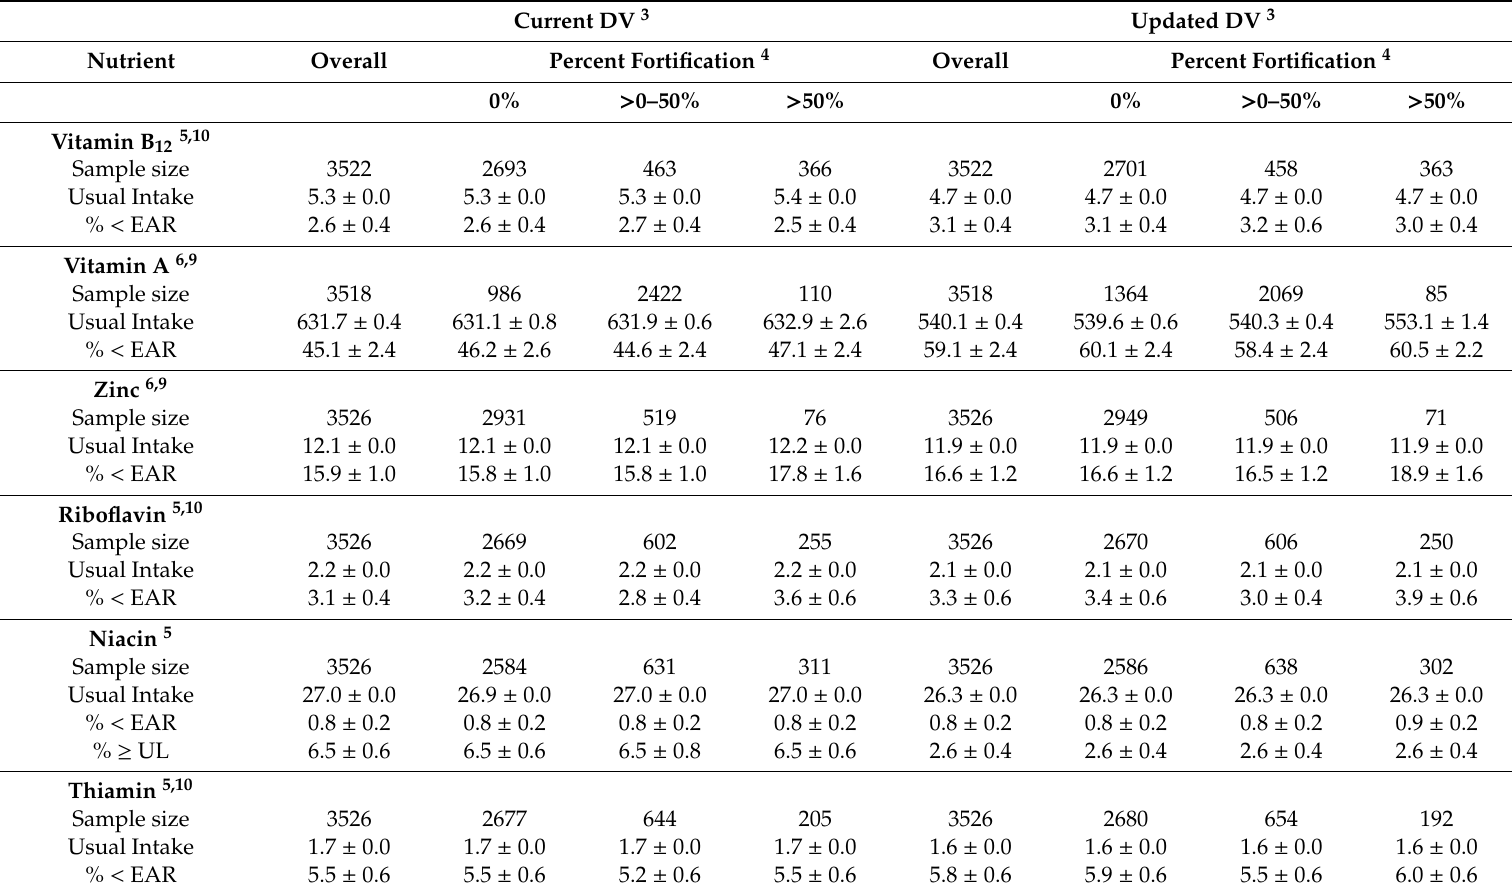
Table A3. Comparison of Current Daily Value (DV) and Updated DV nutrient intake models with overall and percent fortification subgroups for US adults (31–50 years of age) 1,2 (Mean ±